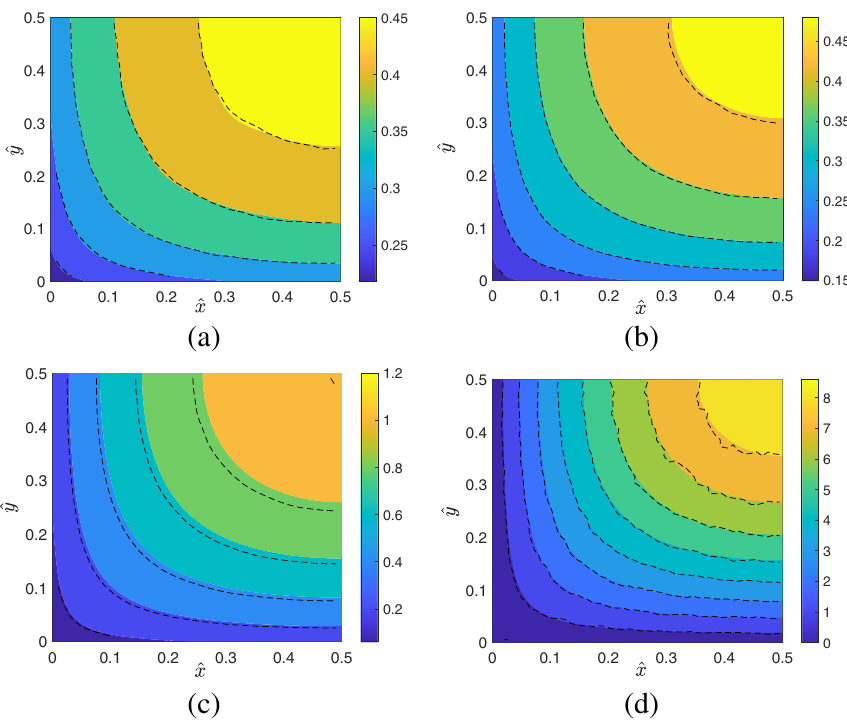
Fig. 5 2D velocity contours and isolines in the 2D Poiseuille flow. Contour maps: the reference solutions from GSIS-DVM. Dotted contour lines: GSIS-LVDSMC results. a Kn